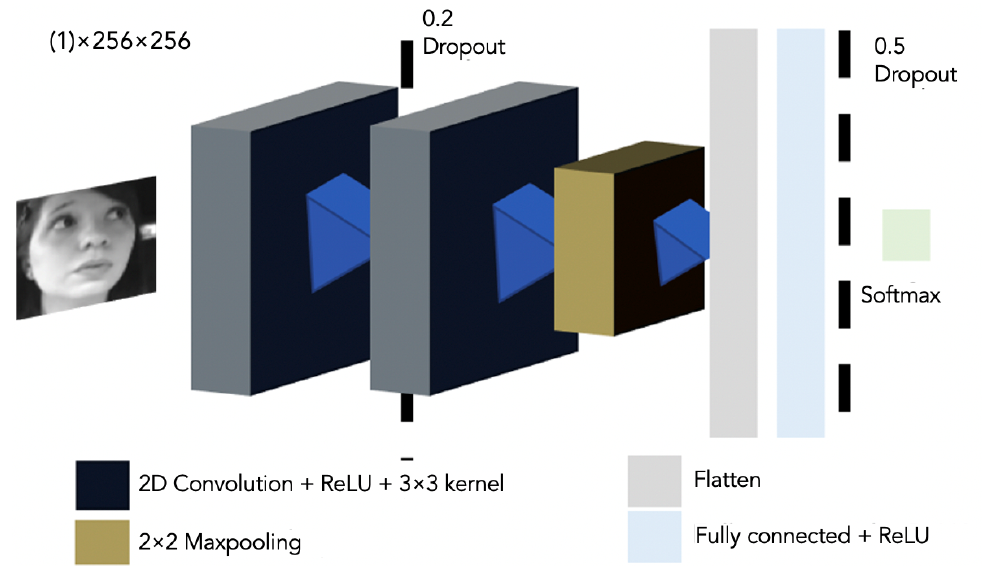
Figure 2. Two-dimensional CNN Network Architecture used to predict the six different proposed standard driving gaze areas with a one-channel (1) image